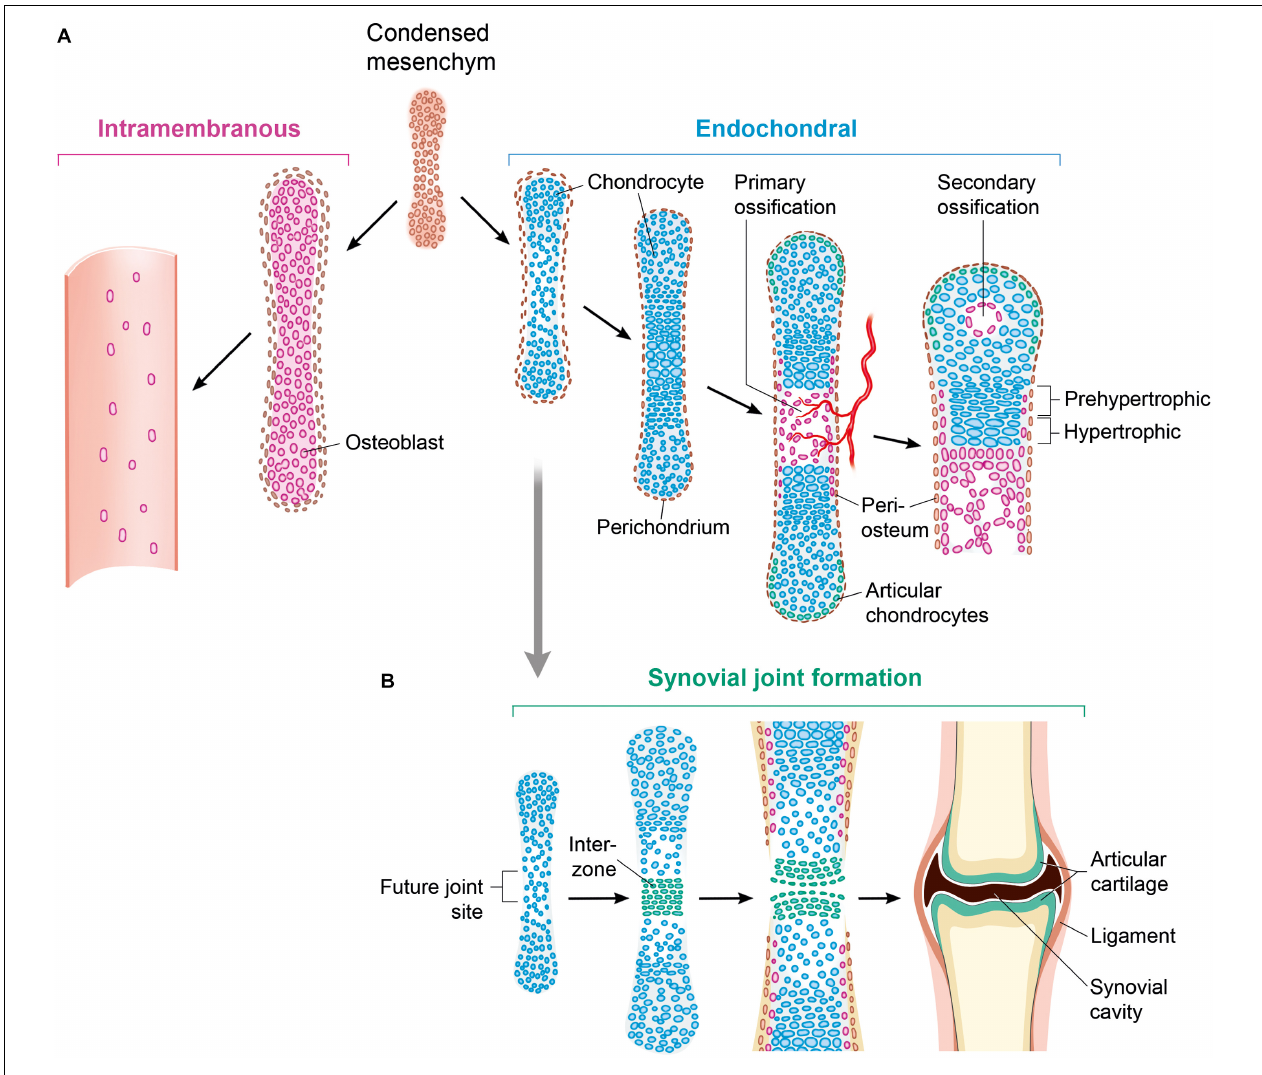
FIGURE 1 | Ways of bone formation. (A) Ossification can occur via endochondral or intramembranous mechanisms. As part of the intramembranous ossification, mesenchymal cells differentiate directly into osteoblasts and generate bone tissue. Chondrocytes develop from mesenchymal cell differentiation with forming an intermediate cartilage during endochondral ossification. By mineralizing the matrix, undergoing apoptosis and attracting blood vessels and osteoblasts, hypertrophying chondrocytes that stop proliferating initiate a centric growth plate. (B) Histologically detectable flattening and gathering of cells that are forming an interzone, is the first sign of joint formation. This is followed by maturation and remodeling leading to a mature synovial joint. The Wnt signaling pathway is crucial for controlling almost all aspects of this skeleton formation. Osteoblasts (purple); chondrocytes (blue); osteochondroprogenitor cells